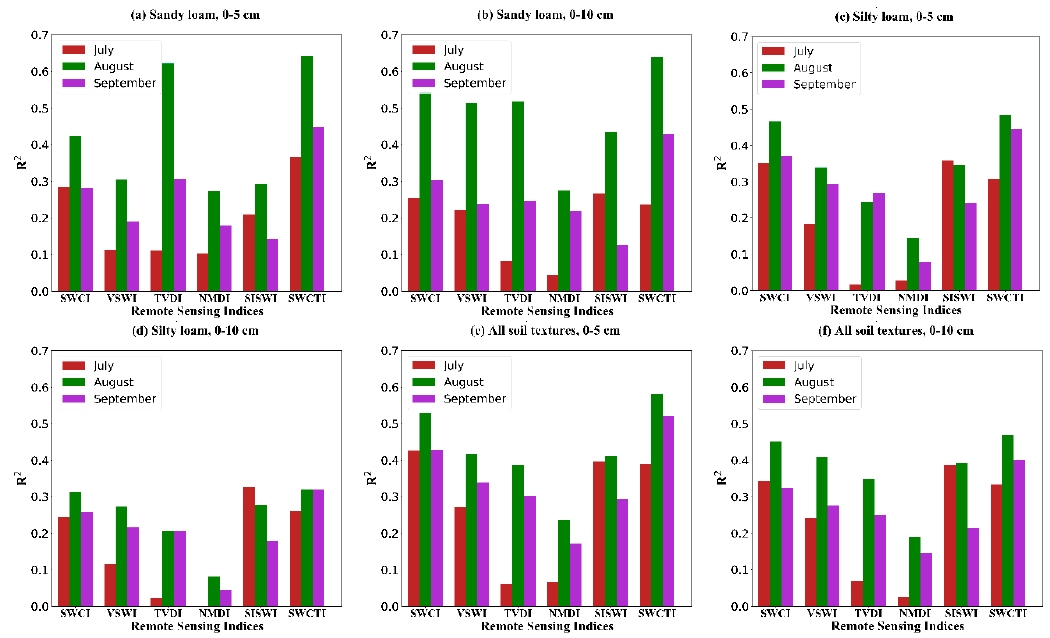
Figure 12. Correlation between remote sensing indices and soil moisture for different soil depths, different soil textures and different months. ( a – f ) show the correlation for the soil depths of 0–5 cm and 0–10 cm, the soil textures of sandy loam and silty loam and all soil textures, the months of July, August and September, respectively.